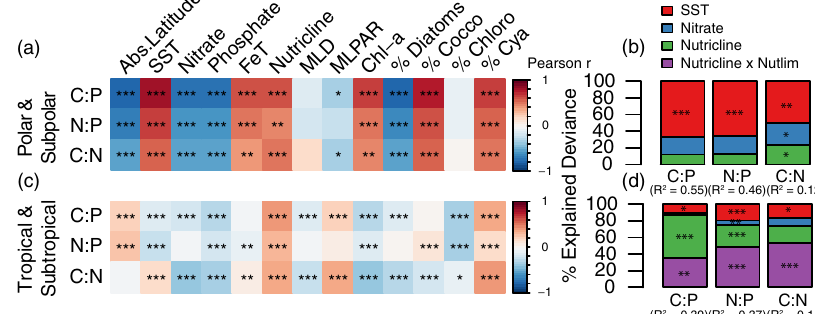
Fig. 3 Predictors of ecosystem C:N:P. a , c Correlation of contextual variables with the C:N:P ratios. The color of the tiles is the Pearson r correlation coef fi cient. Asterisks represent the statistical signi fi cance (*** p < 0.001, ** p < 0.01, *: p < 0.05). b , d The individual explained deviance and additive contribution of the four main contextual variables normalized to the total explained deviance in GAMs. The bracket number is deviance explained ( R 2 ), by the full model, which equals the sum of deviance explained by the individual variable. a , b corresponds to the data collected in the (sub)polar regions with |Latitude| ≥ 45° ( n = 145), and the c , and d corresponds to the data collected in the (sub)tropical regions with |Latitude| < 45° ( n = 1825). additive models (GAMs). While the correlation analysis can cap- 65% of the total explained variances for C:P ( R 2 = 0.55), and N:P ture fi rst-order, monotonic relationships between predictors and ( R 2 = 0.46), respectively (Fig. 3b, Supplementary Table 7). C:P and C:N:P, GAMs detected nonlinear, non-monotonic relationships N:P increased linearly from the coldest polar regions to the warmer amongst C:N:P and in situ measurements of sea surface tempera- subpolar regions, coinciding with a gradual community composi- ture (SST), nutrient availability, and nutrient limitation type. tion shift from diatom to coccolithophore dominance (Fig. 3a). Nutricline depth (here de fi ned as the depth at which nitrate con- Here, phytoplankton-group relative abundance was obtained from centration equals 1 μ mol kg − 1 ) is used as a proxy of nutrient supply the NASA Ocean Biogeochemical Model 38,39 at the closest grid rate, where deeper nutricline indicates a lower nutrient supply rate point to the spatial position of each POM sampling point. Nitrate to the upper mixed layer of the ocean 37 . Overall, we found that the and phosphate concentrations were signi fi cantly negatively corre- dominant environmental predictors of surface ecosystem C:N:P lated with C:N:P across high latitudes, but macronutrient con- differed between high and low-latitude regions (Fig. 3). In (sub) centrations were not as good of a predictor for C:N:P as SST polar regions, SST was strongly positively correlated with C:P and (Fig. 3b, Supplementary Fig. 2). Nutricline could not explain var- N:P (Fig. 3a, Supplementary Table 5, 6), and SST captured 67% and iances in C:N:P as the surface nitrate concentrations exceeded COMMUNICATIONS EARTH & ENVIRONMENT| (2022) 3:271 |https://doi.org/10.1038/s43247-022-00603-6|www.nature.com/commsenv